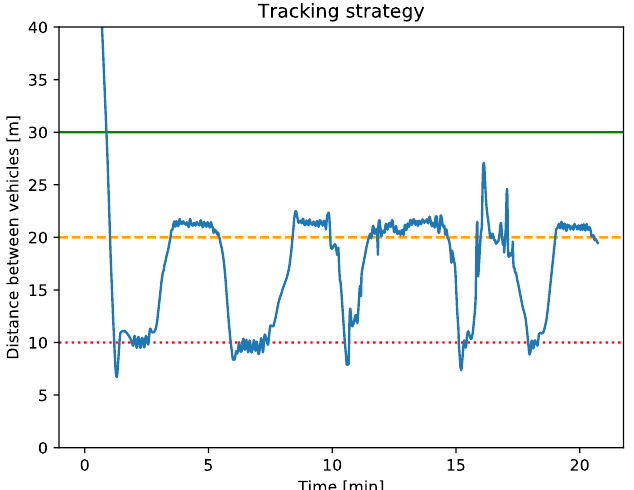
Figure 13. The blue line represents the (X, Y) distance between the AUV and the ASV in meters. The red dotted line represents the repulsion radius (10 m), the orange dashed line represents the adrift radius (20 m), and finally, the green line represents the tracking radius (30 m).